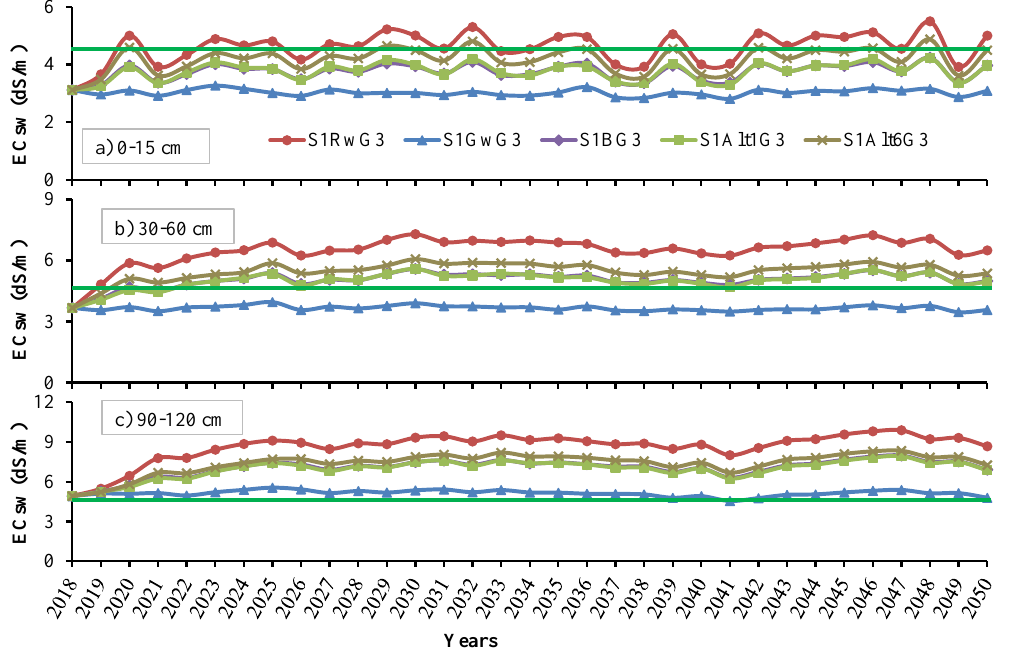
Figure 2. Impact of different water qualities (recycled water, RW; good water, GW; blending of RW and GW in a 1:1 ratio, B; RW and GW used in monthly cycles, Alt1; and RW and GW used in half-yearly cycles, Alt6) and annual gypsum applications of 8.6 t/ha (G3) on EC sw for calcareous soil (S1) under wine grape cultivation.